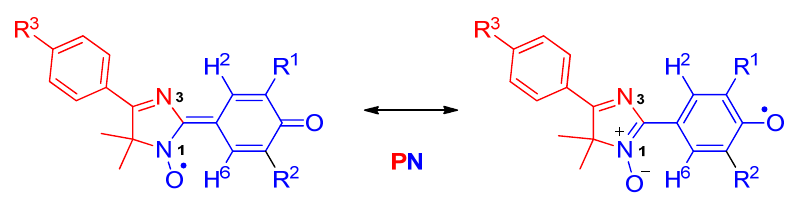
Figure 1. Chemical structures of HPNs 22a–o.